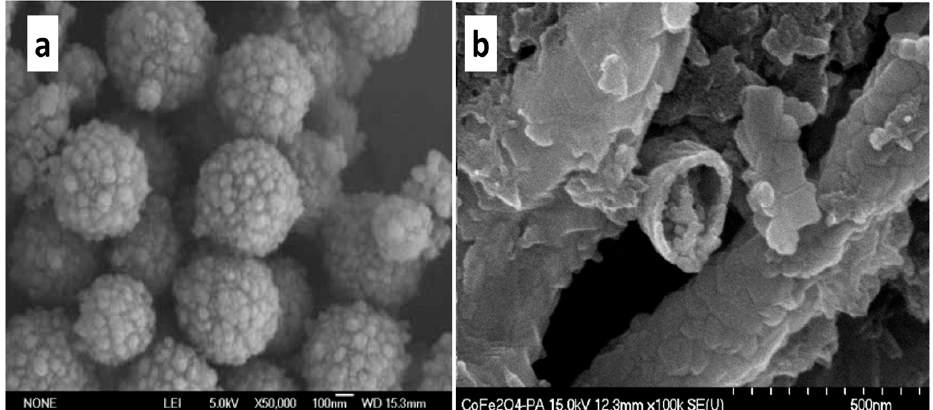
Figure 1. ( a ) SEM image of the as-prepared Fe 3 O 4 /PANI core/shell composite [54]. ( b ) CoFe 2 O 4 /PANI hollow nanofibers [29].